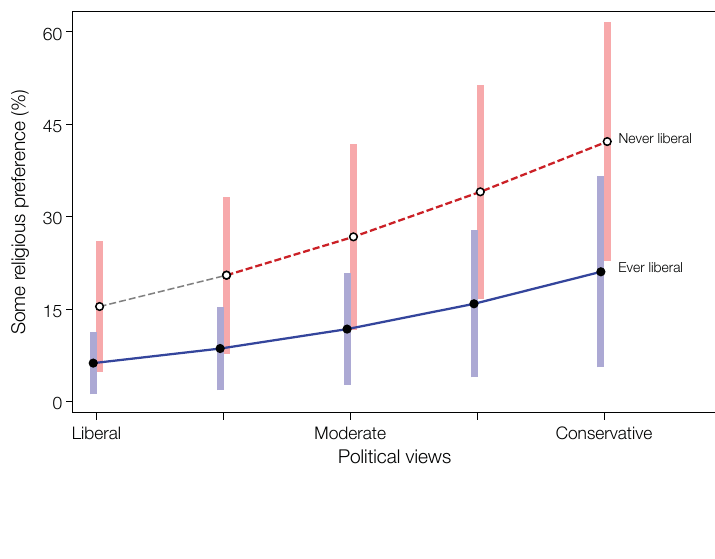
Figure 8b: Percentage with Some Religious Preference by Political Views: Persons Born 1966–1975, Raised with Religion, Attended Religious Services Less Than Once a Month,